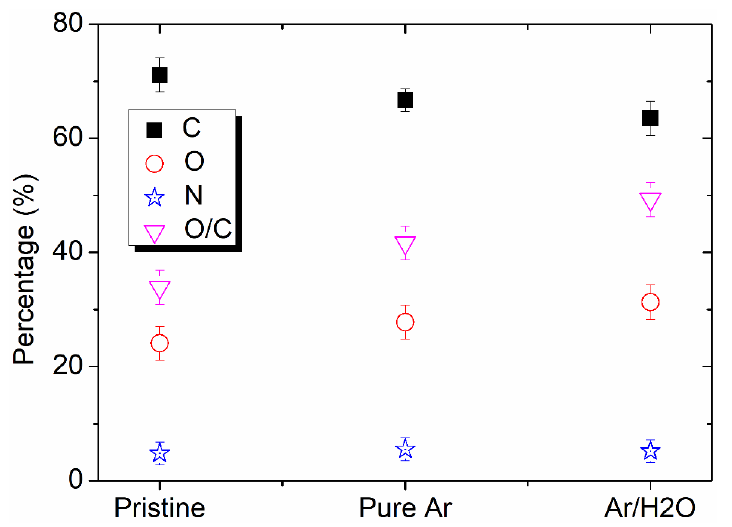
Figure 9. Relative percentages of C, O, N and O/C of pristine, pure Ar and Ar/H 2 O microplasma-jet-modified PI films.